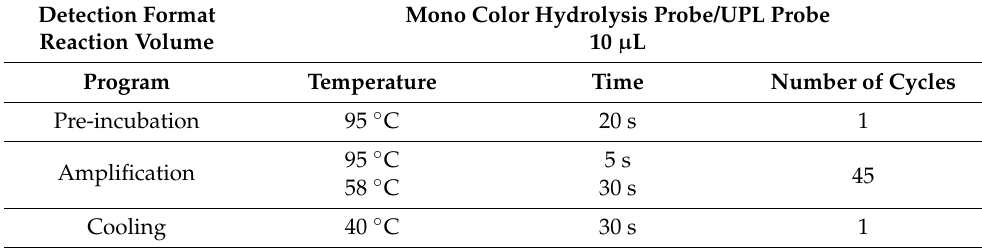
Table 5. RT-qPCR reaction setting for Taq-Man.